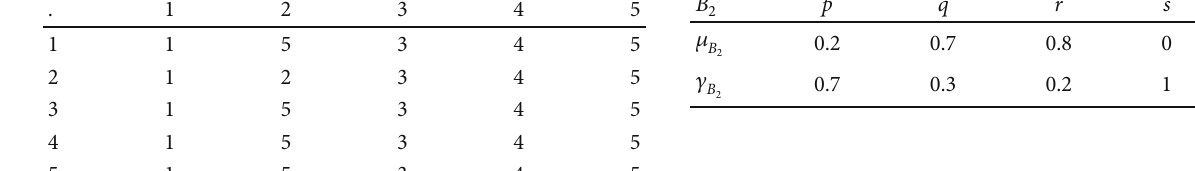
Table 5: Multiplication table for U .